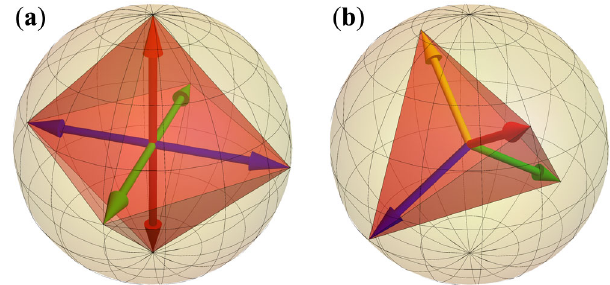
FIG. 1. Bloch sphere representation of two different informa- tionally complete measurements of a qubit. (a) MUB measure- ment has six measurement outcomes that correspond to vertices of an octahedron. (b) SIC POVM measurement has four meas- urement outcomes that correspond to vertices of a tetrahedron.